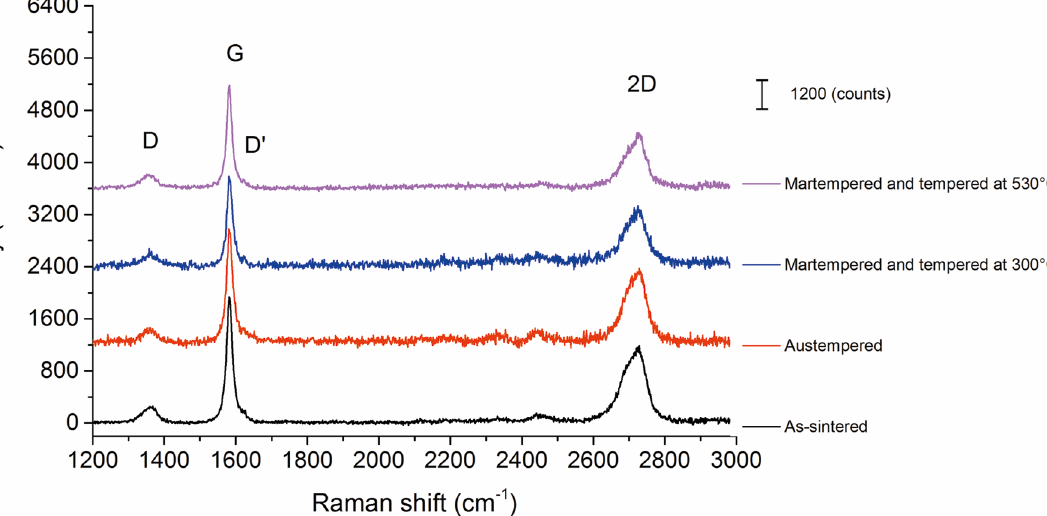
Figure 7. Raman spectra for samples of base alloy + 3 %